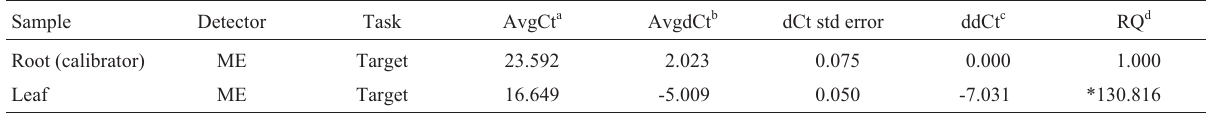
a Avg Ct indicates the average of the C T values (threshold cycles) obtained for three triplicates. b AvgdCt is determined by subtracting the average actin C T value from the average metallothionein C T value. c The calculation of ddCt involves subtracting dCt calibrator value (root) from the dCt target value (leaf). d *Relative quantification is given as the fold expression change given by the equation 2 -ddCt .